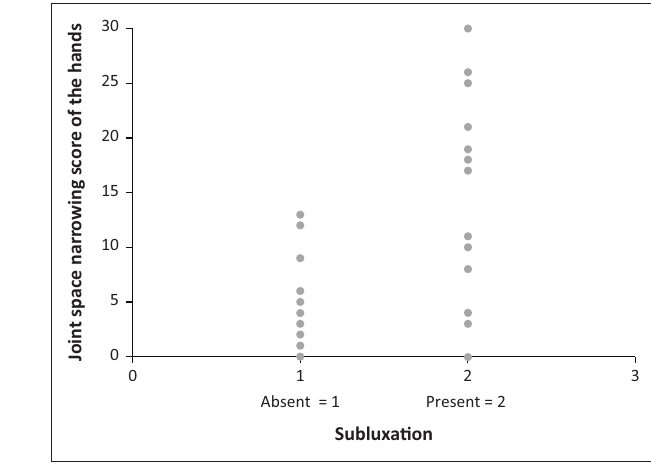
FIGURE 4: Correlation between the joint space narrowing score of the hands and the prevalence of cervical spine subluxation.